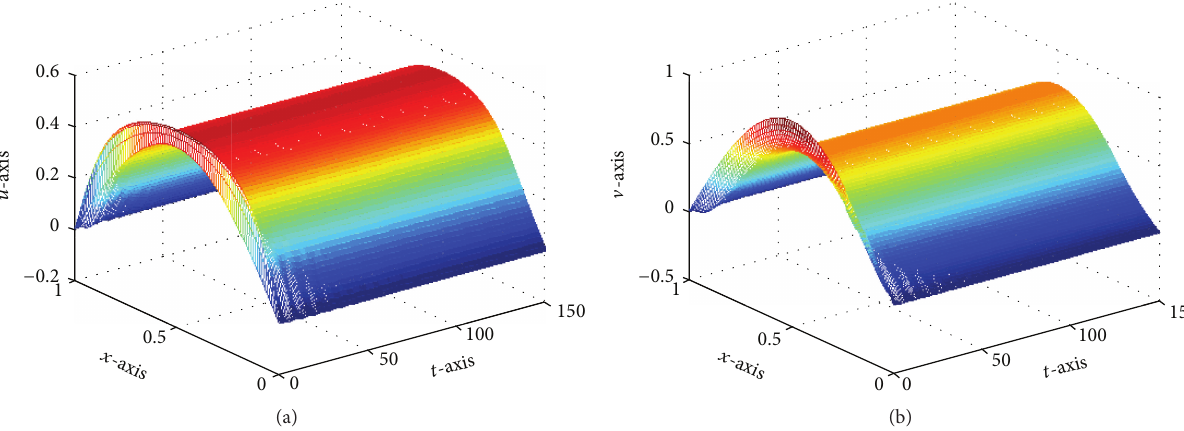
Figure 3: The temporal solution found by numerical integration of systems (67) and (69) with 𝜏 = 1.25 : (a) 𝑢(𝑡,𝑥) and (b) V (𝑡,𝑥)